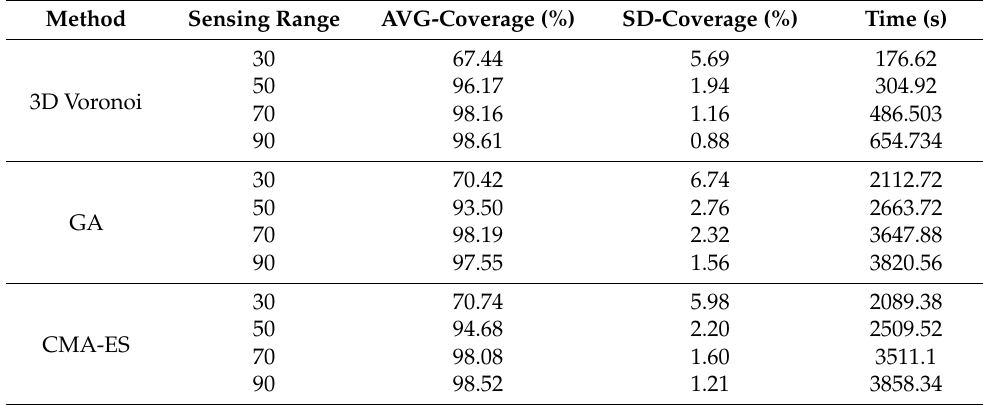
Table 2. Results of 3D Voronoi, GA, and CMA-ES algorithms for four cameras.